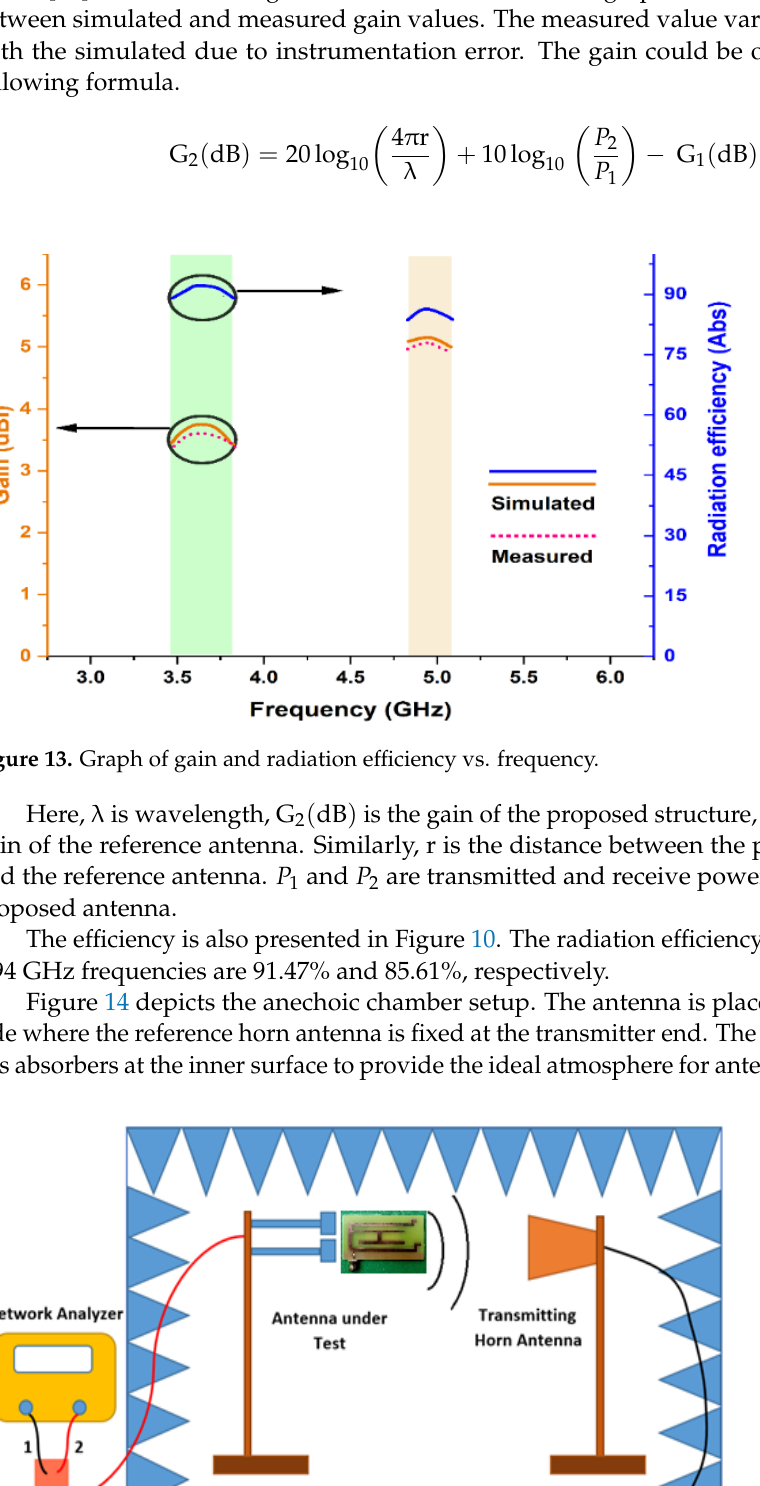
Figure 14. Anechoic chamber set up.